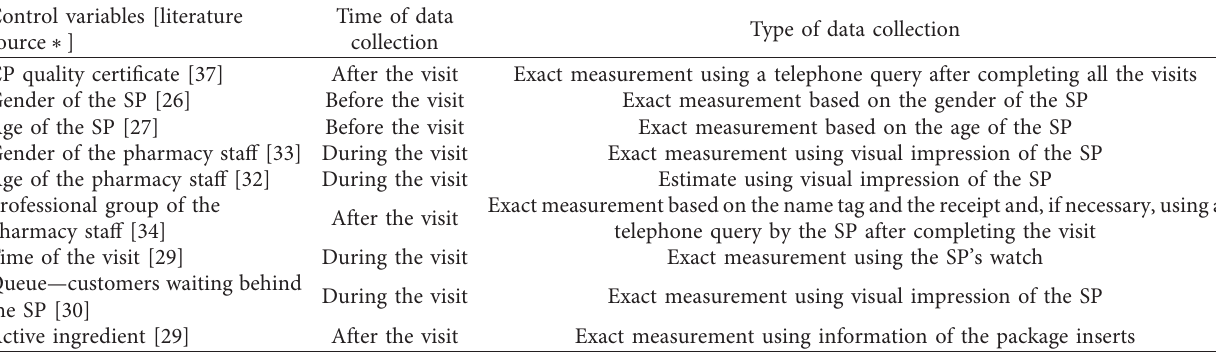
Table 4: Control variables as well as time and type of data collection.